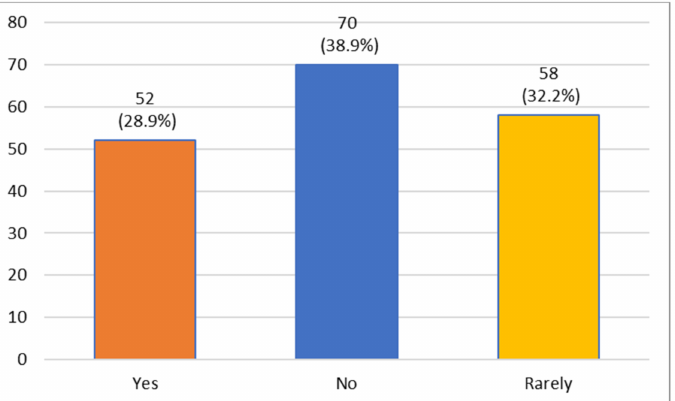
Figure 5. Distribution of the answers given by children regarding organic products. An increased number of children (75.6%, n = 136) have breakfast while only a few have breakfast occasionally (13.9%, n = 25) or none (10.6%, n = 19) (Figure 6).